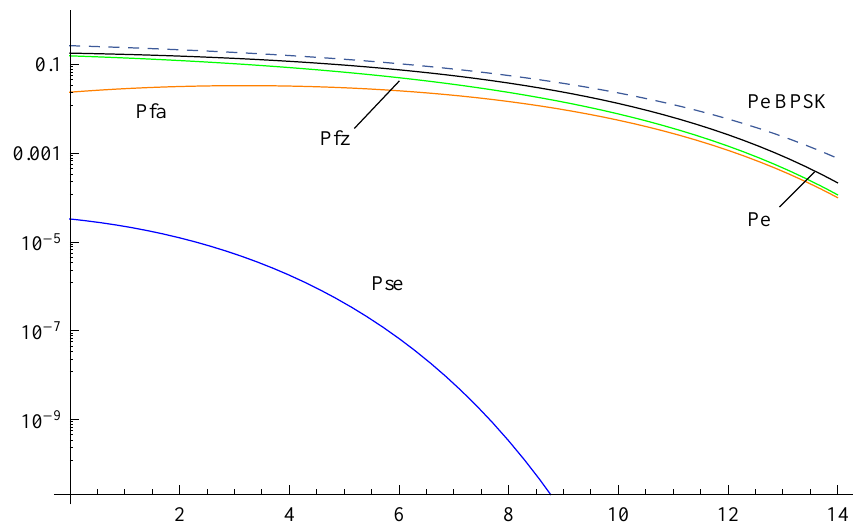
Figure 2. Error probabilities of the Z-BPSK and BPSK for P 0 = 0.8 as a function of the SNR γ = E s / N 0